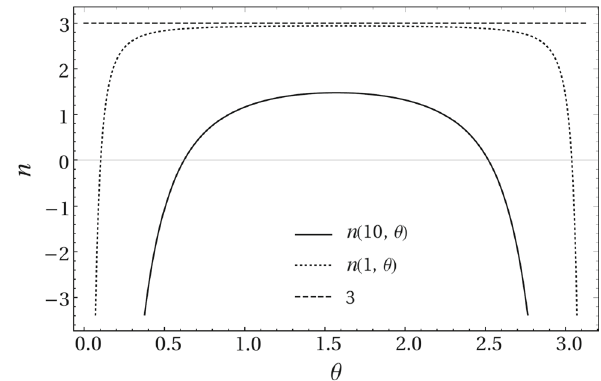
Fig. 3 The braking indices are functions of magnetic inclination angle for fixed acceleration. The accelerations of pulsars are parallel to direc- tion of rotation